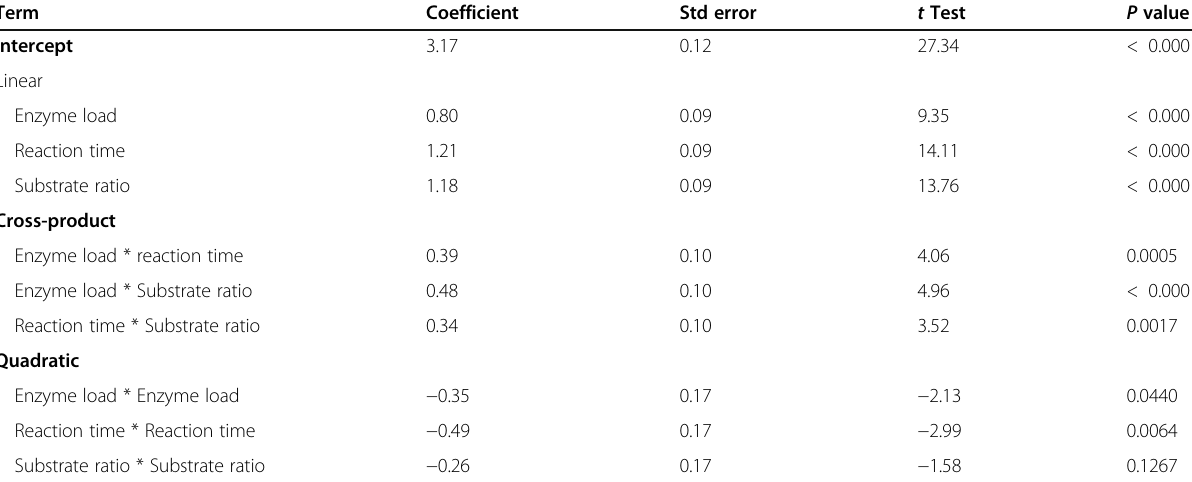
Table 4 Estimated coefficients and corresponding t and P values